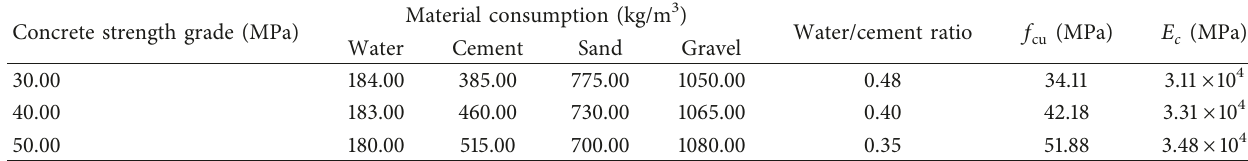
Table 3: Material consumption and mechanical properties of concrete.